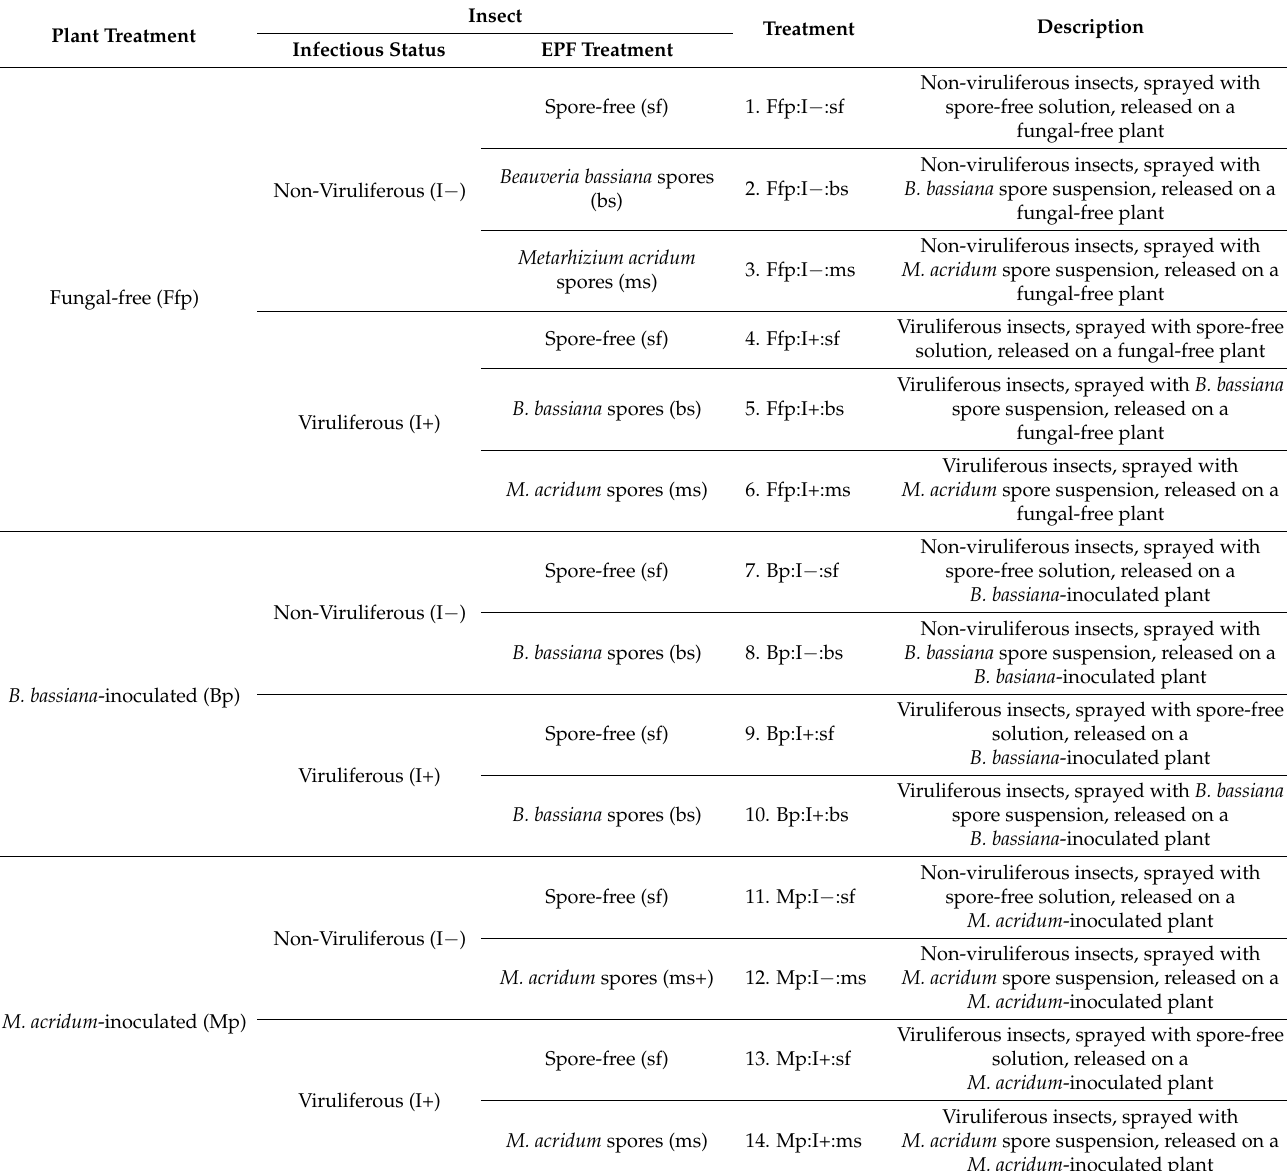
Table 1. Different treatment combinations in the insect fitness bioassays. I+: viruliferous, I − : non-viruliferous. Plant